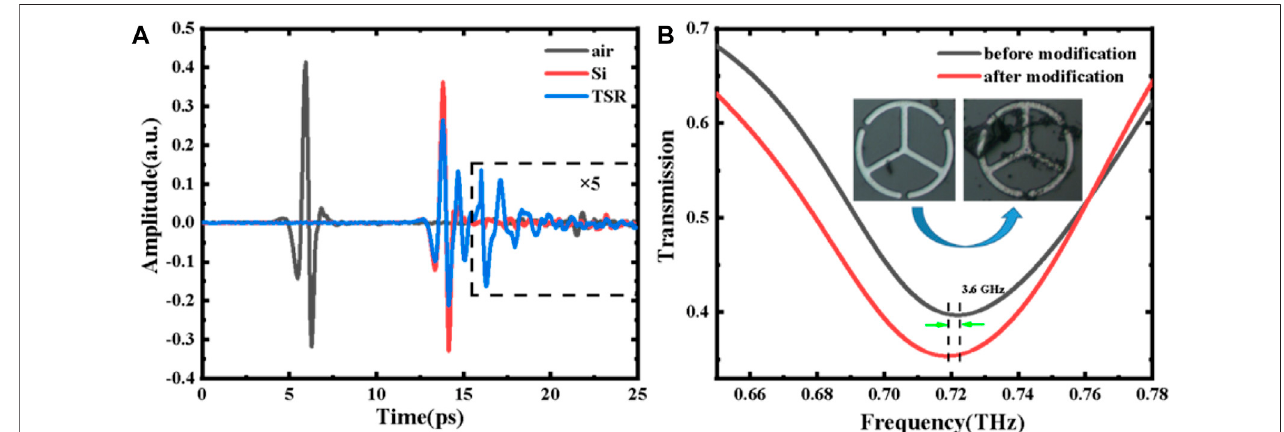
FIGURE 6 | (A) Measured time-domain waveforms. (B) Comparison of the transmission spectra of the proposed MM sensors before and after modi fi cation (TSR and 0 μ g/ml). The inset shows the microscopy images of the sample (TSR, 0 μ g/ml).